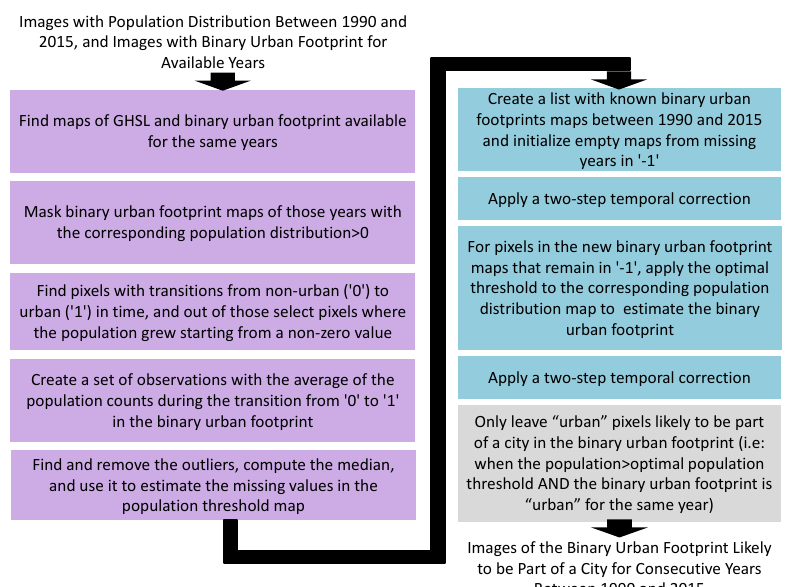
Figure 6. Flow diagram with the harmonization process of the binary urban footprint using the population distribution. It has three main sub-processes that have been color-coded. The first sub-process finds the optimal threshold after which an area is considered urban. The second sub-process estimates the binary urban footprint for missing years using available information, a temporal correction, and the optimal threshold. The third sub-process cleans the binary urban footprint and only leaves urban pixels that are likely to be part of a